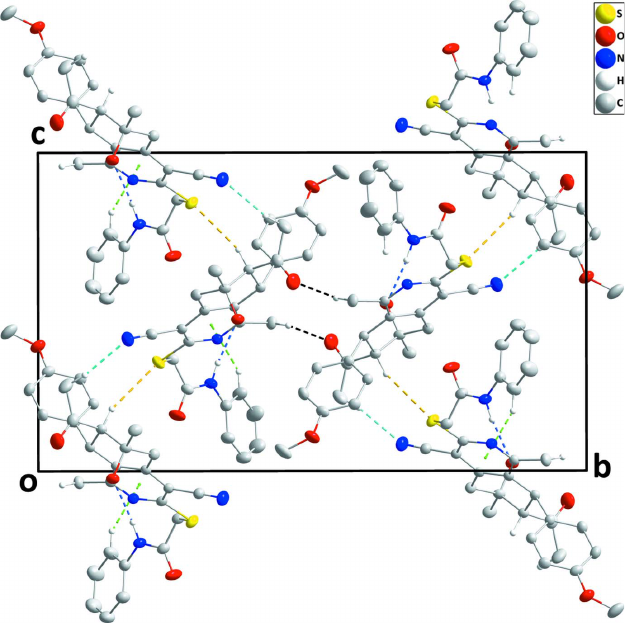
Figure 2 View of a portion of one layer seen along the b -axis direction. N—H (cid:2)(cid:2)(cid:2) O, C—H (cid:2)(cid:2)(cid:2) N and C—H (cid:2)(cid:2)(cid:2) S hydrogen bonds are depicted, respectively, by dark-blue, light-blue and yellow dashed lines. C—H (cid:2)(cid:2)(cid:2) (cid:2) (ring) inter- actions are depicted by green dashed lines.